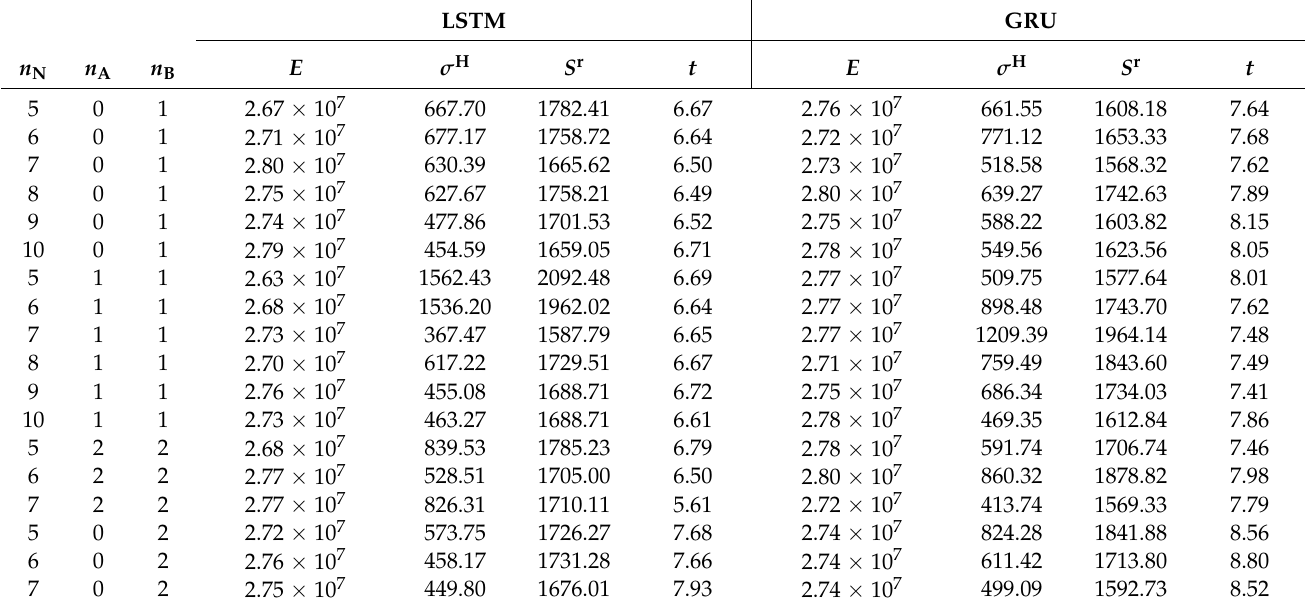
Table 5. The polymerisation reactor: quality indexes and average time of calculation comparison.